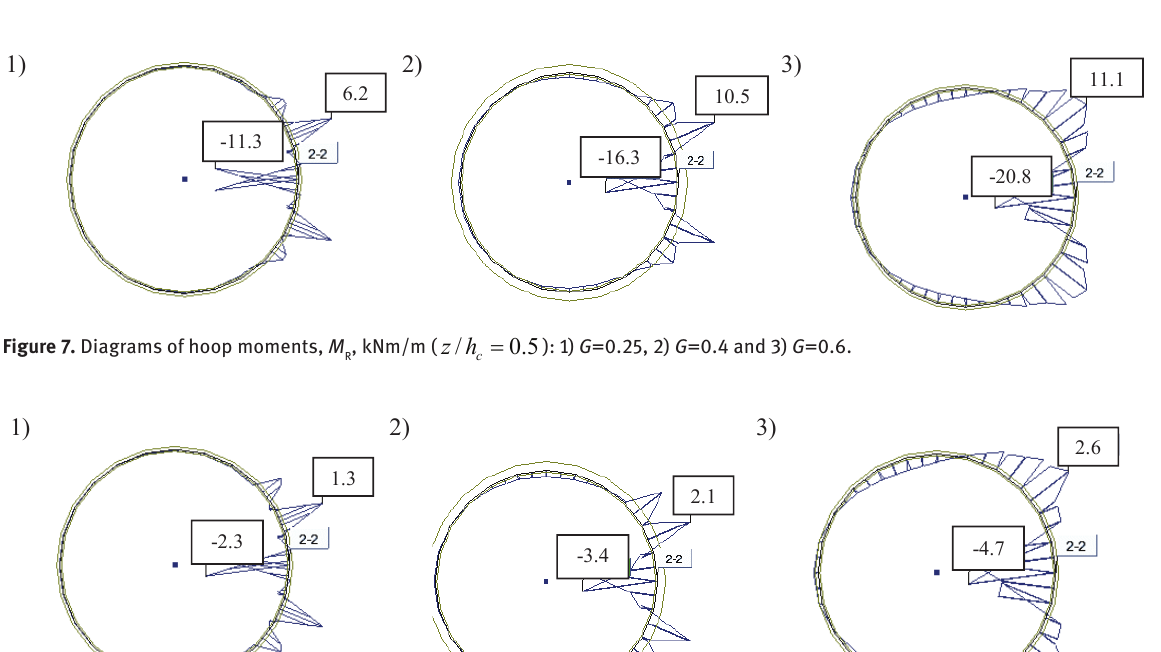
Figure 6: Maps of internal forces during emptying of the silo with the diameter d Fig. 6. Maps of internal forces during emptying of the silo with the diameter occurrence of non-centric flow channel with the radius r eccentric taking into account the occurrence of non-centric flow channel with the radius rr